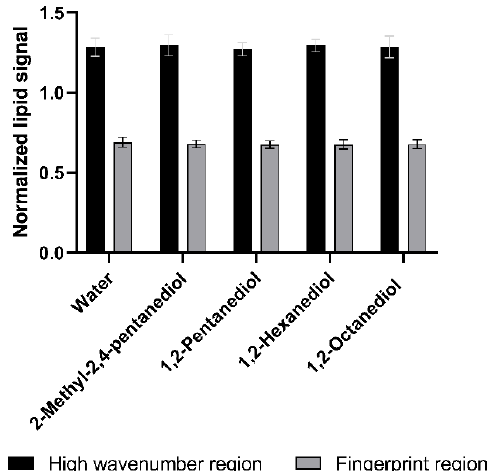
Figure 6. Normalized lipid signals in high wavenumber and fingerprint regions for lipid